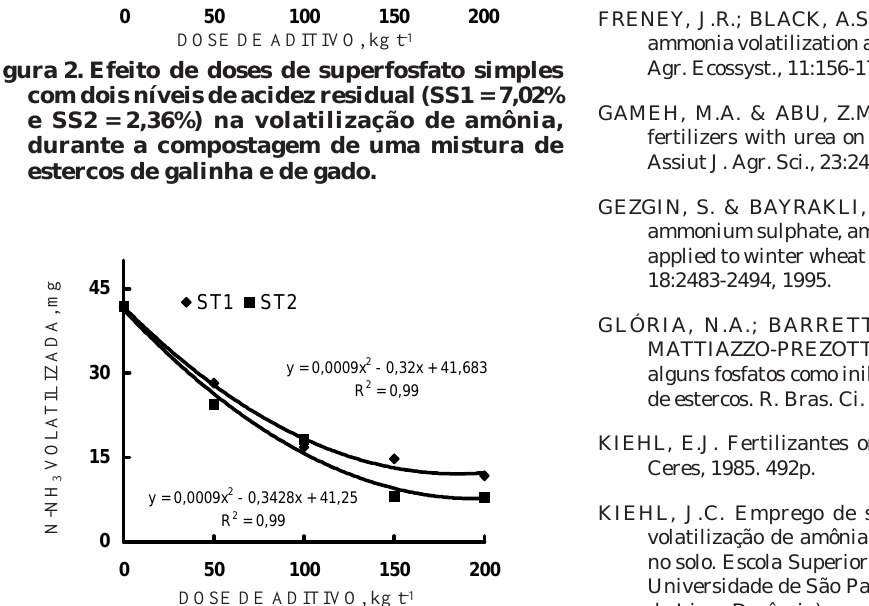
Figura 3. Efeito de doses de superfosfato triplo com dois níveis de acidez residual (ST1 = 2,38% e ST2 = 1,86%) na volatilização de amônia, durante a compostagem de uma mistura de estercos de galinha e de